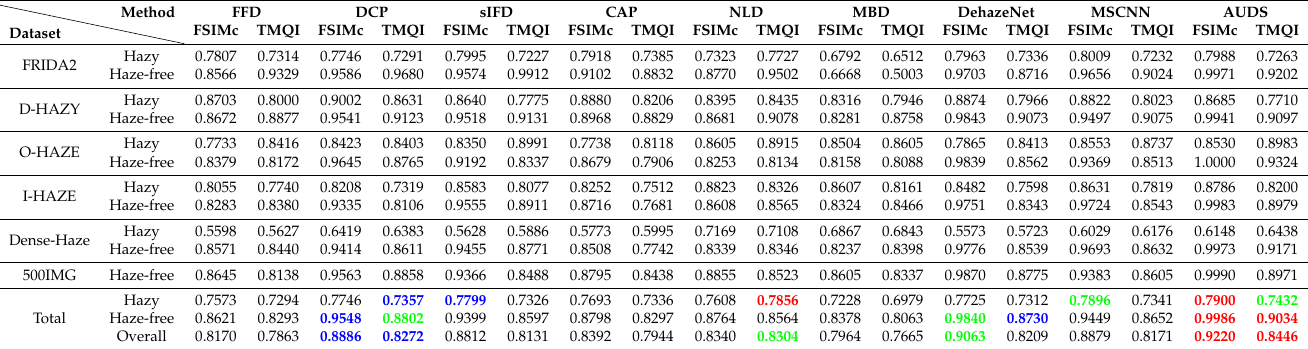
Table 4. Average quantitative results on different datasets. Top three results are boldfaced in red, green, and blue.